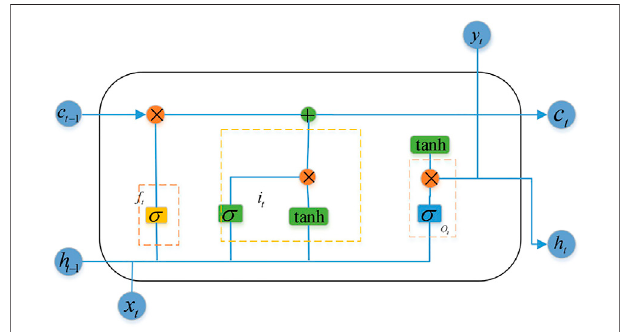
FIGURE 1 | The structure of LSTM-based